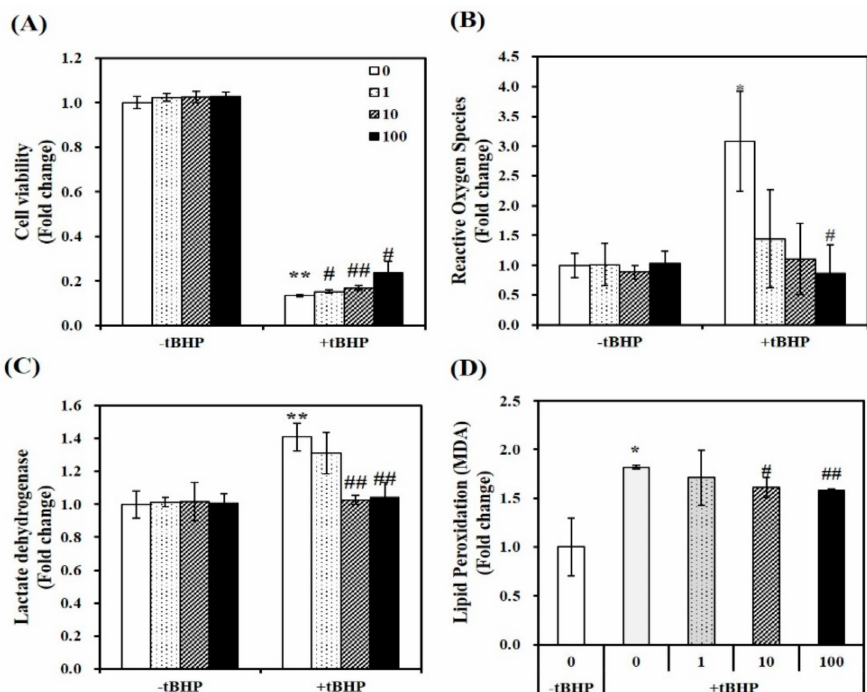
Figure 1. E ff ect of 1,25-dihydroxyvitamin D (1,25(OH)2D) on cell viability, oxidative stress, lipid peroxidation, and cellular damage in tertiary butyl-hydrogen peroxide-treated C2C12 muscle cells. On day 6 after di ff erentiation induction, C2C12 muscle cells were incubated with tBHP (0.1 mM, 24 h) and treated with 1,25(OH)2D for additional 24 h in a dose-dependent manner (0, 1, 10, or 100 nM). The dissolved blue formazan ( A ), reactive oxygen species (ROS) ( B ), lactate dehydrogenase (LDH) levels ( C ) , and lipid peroxidation (MDA) ( D ) were measured and expressed as the fold change compared to vehicle control. Data are expressed as mean ± SEM. Experiments represent at least two or three independent experiments ( n = 6–14 per group). * p < 0.05, ** p < 0.01 compared to vehicle control. # p < 0.05; ## p < 0.01 compared to tBHP